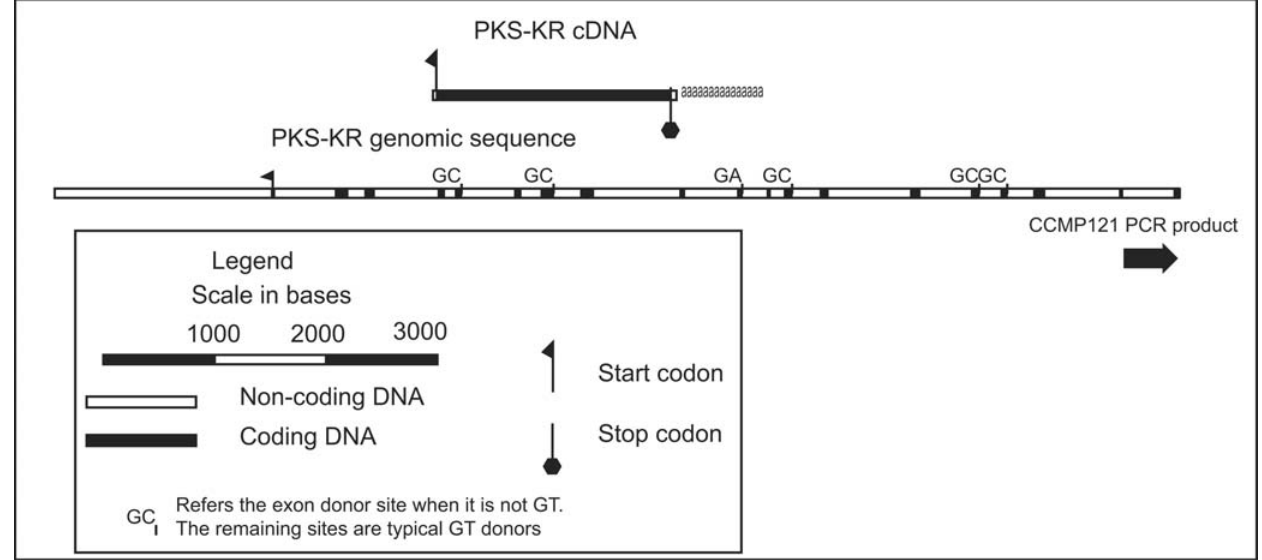
Figure 8. A scaled schematic representation of the polyketide synthase (PKS) genomic and cDNA sequence. Exons, donor sites, and the start codon are shown, the genomic sequence does not extend to the stop codon, but does extend well upstream of the start codon. The location of the amplicon from a second toxin-producing strain of Amphidinium carterae CCMP121 is also shown. When atypical intron donors are present the actual dinucleotide donor is shown at the edge of the intron.